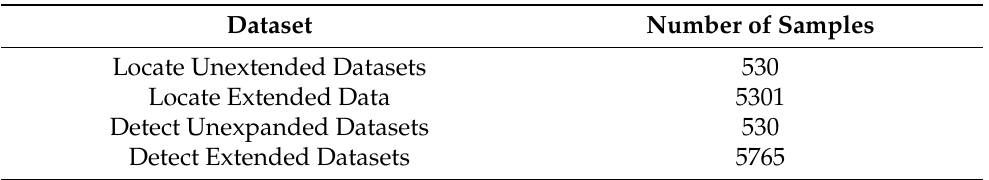
Table 2. Experimental Data Set.